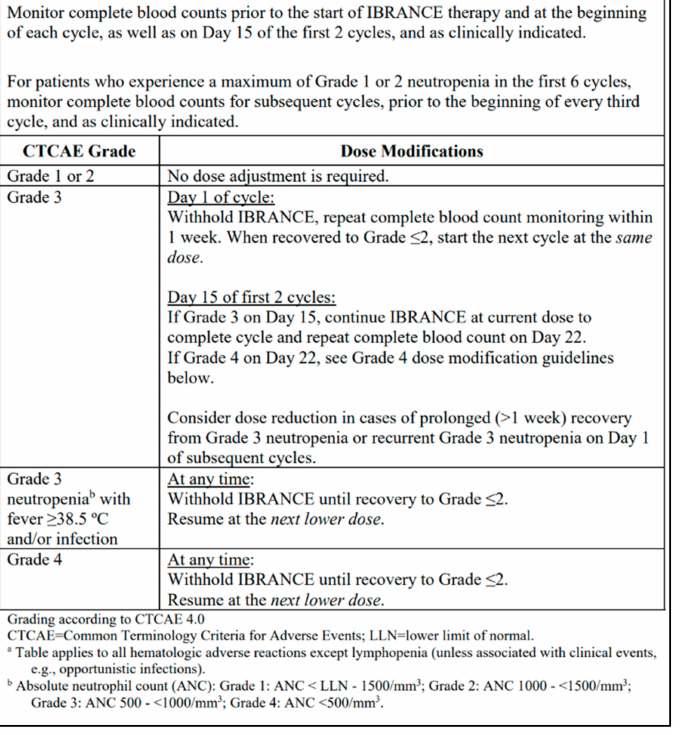
Figure 1. Dosing modifications and management of hematologic toxicities, reprinted from the Ibrance (palbociclib) manufacturer product monograph